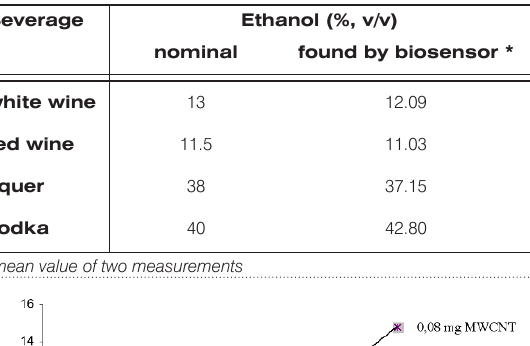
Table 2. Results of ethanol determination in alcoholic beverage samples with ADH/TiO /MB/MWCNT/Nafion biosensor. 2